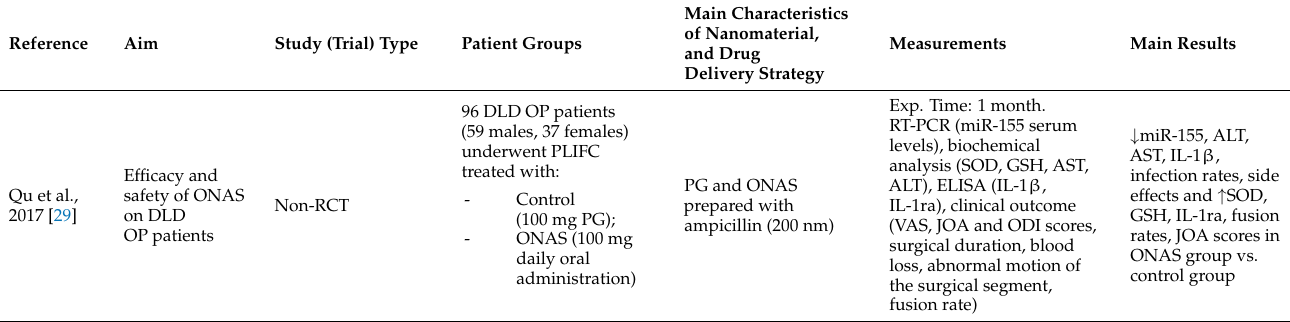
Table 4. Clinical studies on nano-based materials as drug delivery systems in OP